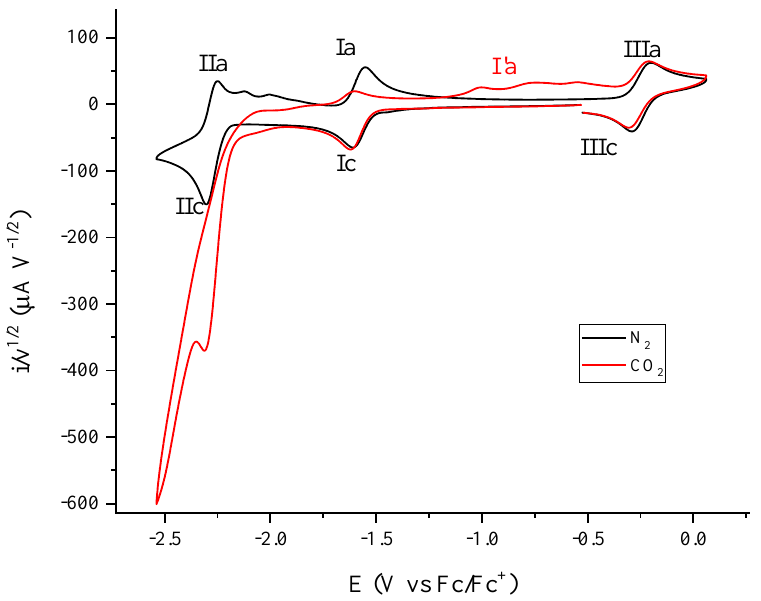
Figure 4. Cyclic voltammetry of a 1 mM [Co II (phen) 3 ](BF 4 ) 2 solution with 0.1 M of TBAPF 6 in MeCN, bubbled with N 2 (black line) and CO 2 (red line). Scan rate of 100 mVs − 1 from open-circuit potential to cathodic direction. Glassy carbon disk as a working electrode.